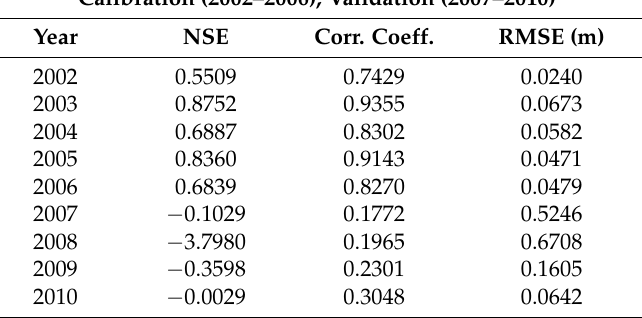
Table 3. Results of neural network downscaling approach with a kriged groundwater surface for calibration.